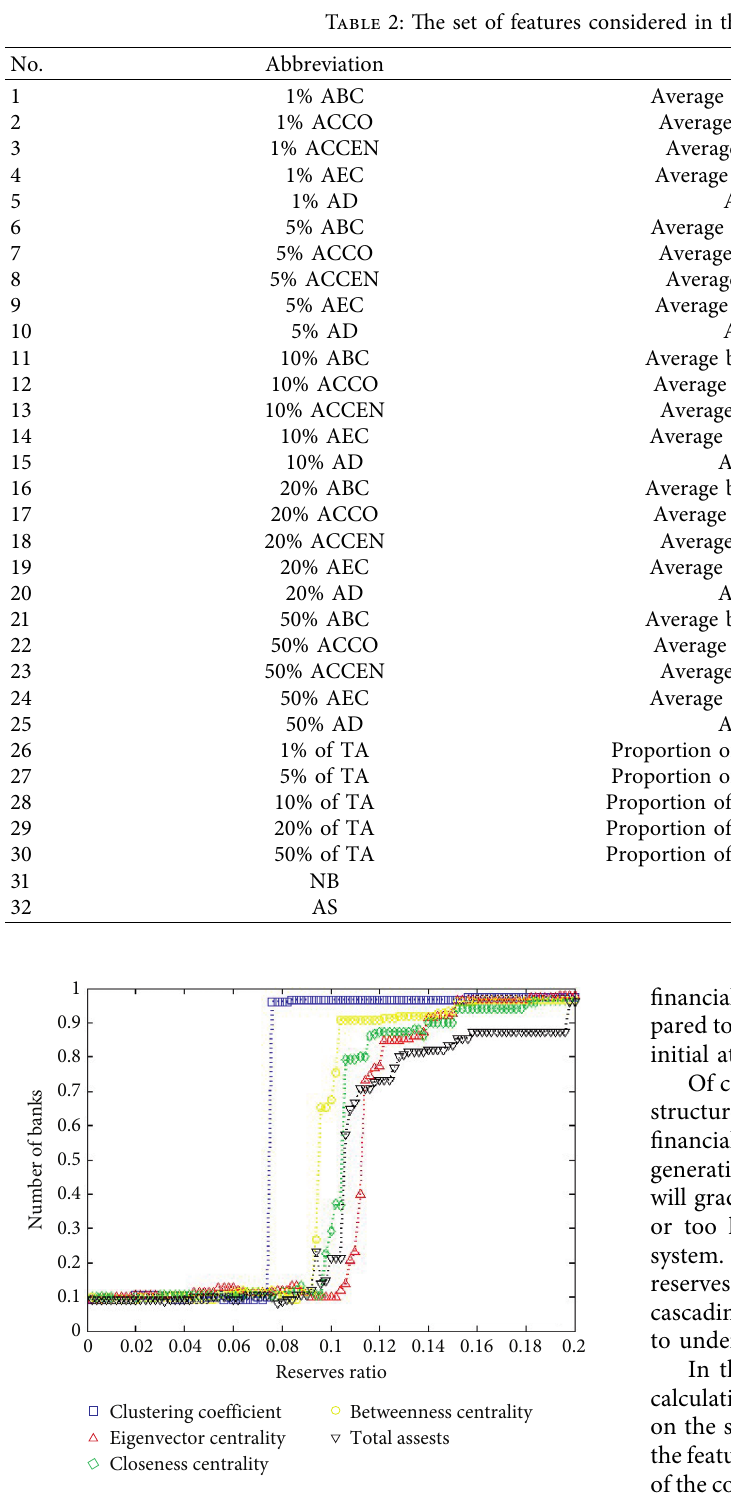
Figure 7: The frontier of cascading defaults with the reserves ratios based on different initial attack